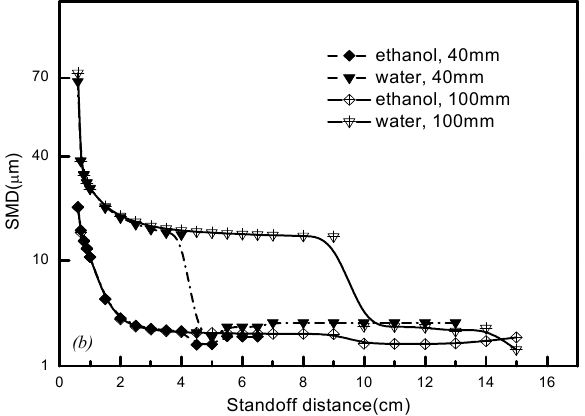
Figure 10. Effects of substrate location on the droplet size in Ar ‐ H 2 plasma gas.